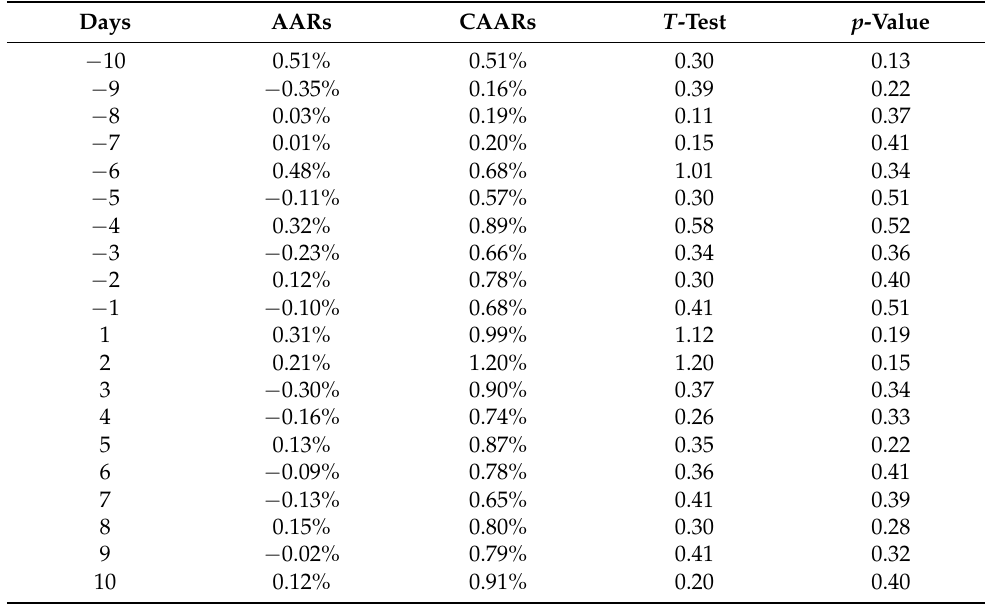
Table 5. Cross-border acquisitions other than in the US and UK.